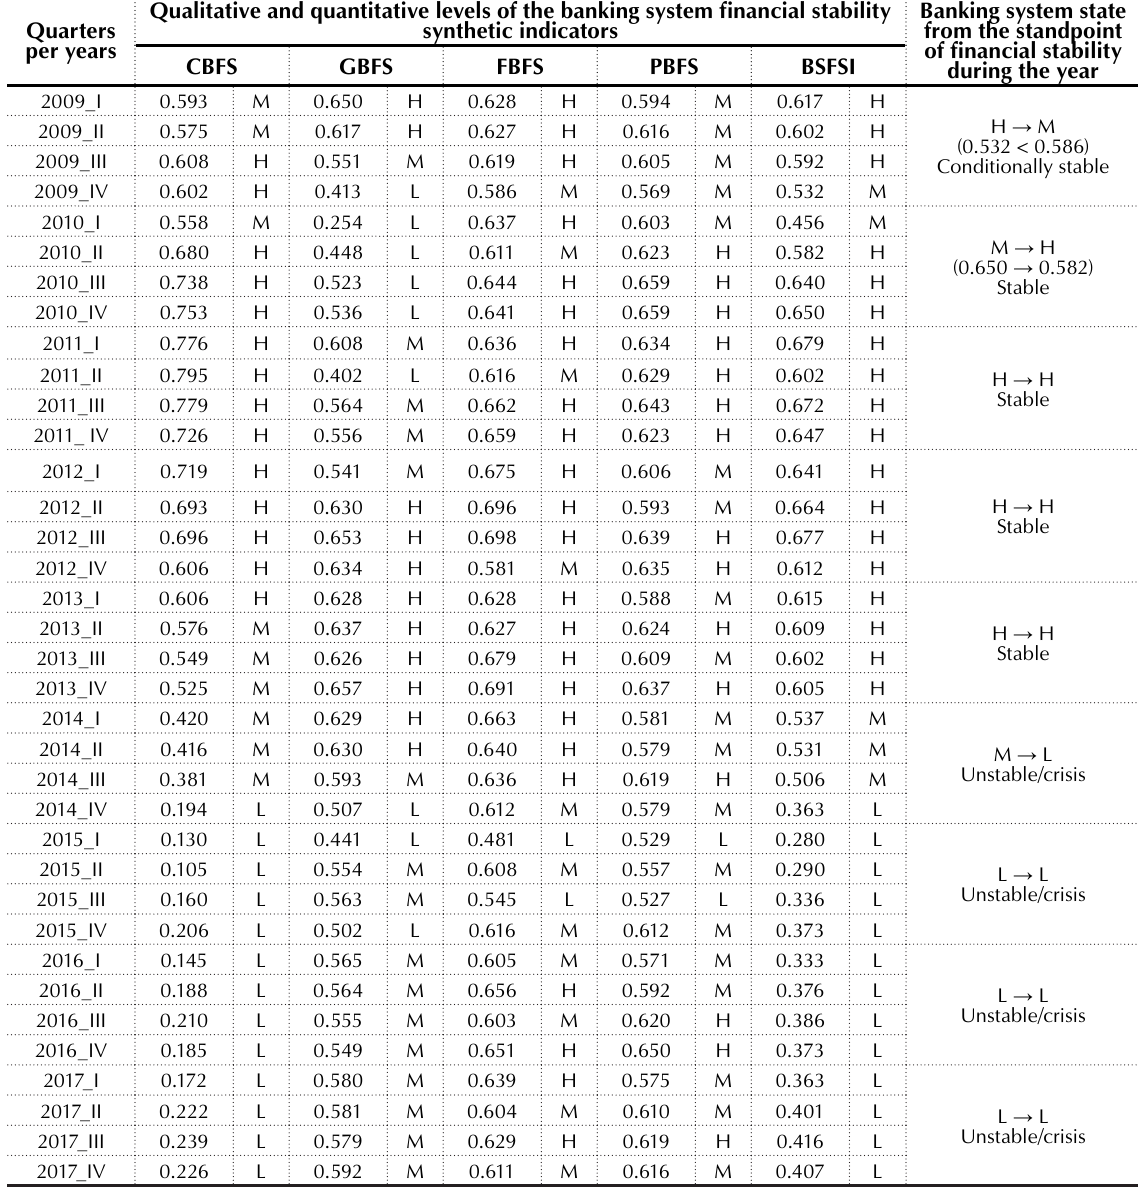
Source: Calculated by the authors. Banking system state from the